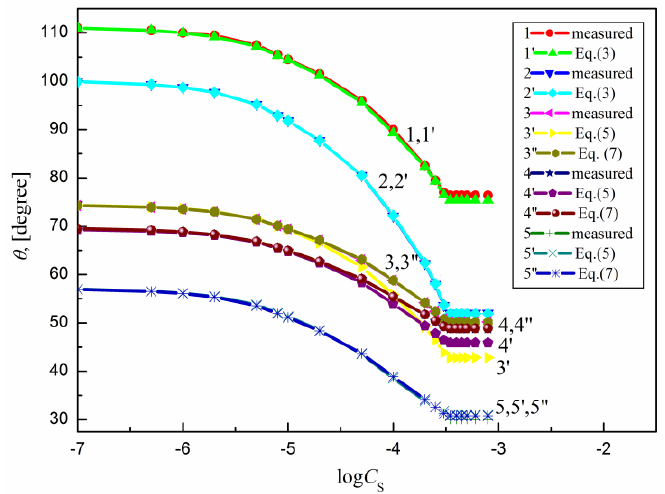
Figure 5. A plot of the contact angle ( θ ) of the aqueous solution of SML on the PTFE (curves 1 and 1 (cid:48) ), PE (curves 2 and 2 (cid:48) ), PMMA (curves 3, 3 (cid:48) and 3 (cid:48)(cid:48) ), nylon 6 (curves 4, 4 (cid:48) and 4 (cid:48)(cid:48) ) and quartz (curves 5, 5 (cid:48) and 5 (cid:48)(cid:48) ) against the logarithm of SML concentration ( C S ). Curves 1–5—the measured θ values, curves 1 (cid:48) and 2 (cid:48) —the θ values calculated from Equation (3), curves 3 (cid:48) , 4 (cid:48) and 5 (cid:48) —the θ values calculated from Equation (5) and curves 3 (cid:48)(cid:48) , 4 (cid:48)(cid:48) and 5 (cid:48)(cid:48) —the θ values calculated from Equation (7). Table 1. The values of critical micelle concentration (CMC) and contact angle at CMC ( θ CMC ) of studied surfactants determined from the contact angle isotherms.